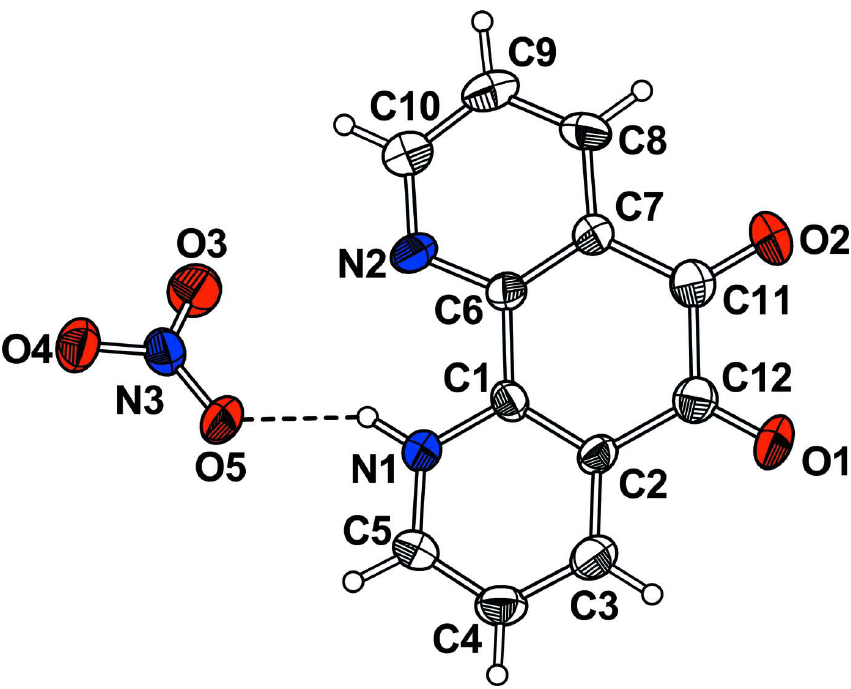
Figure 1 Molecular structure of (I), with 50% probability displacement ellipsoids. H atoms are shown as circles of arbitrary